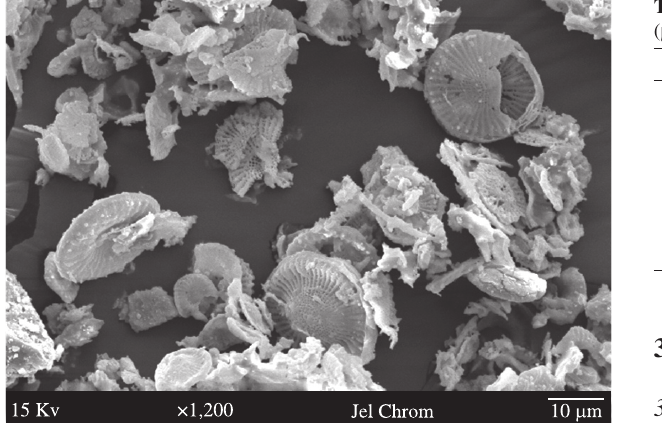
Figure 3. Typical scanning electron photomicrograph of Jeltrate Chromatic Ortho inorganic fraction. Similarly Jeltrate, particles can be seen with circular holes and smaller particles with irregular shapes. These irregular particles are probably the same circular that were broken, since the EDX examination showed the same basic composition.